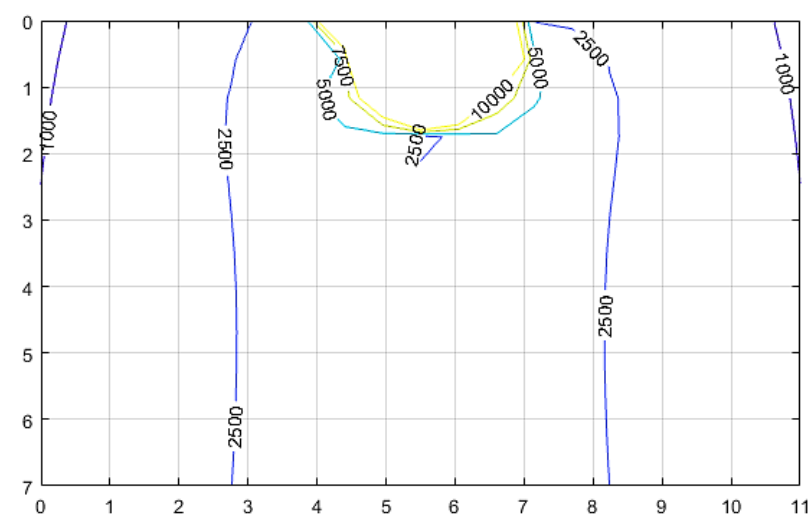
Figure 2: The body force distribution under 10 KN point load after 8640